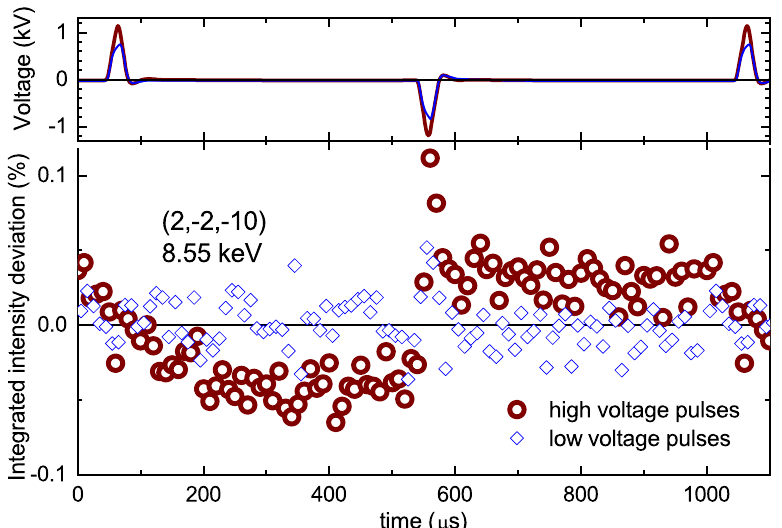
Figure 5. Time-resolved in-situ diffraction experiment. Top: Applied voltage pulses with higher (blue) and lower (brown) maximum voltage. Bottom: Corresponding normalized deviation from average of the integrated intensity of the (2,2,10)